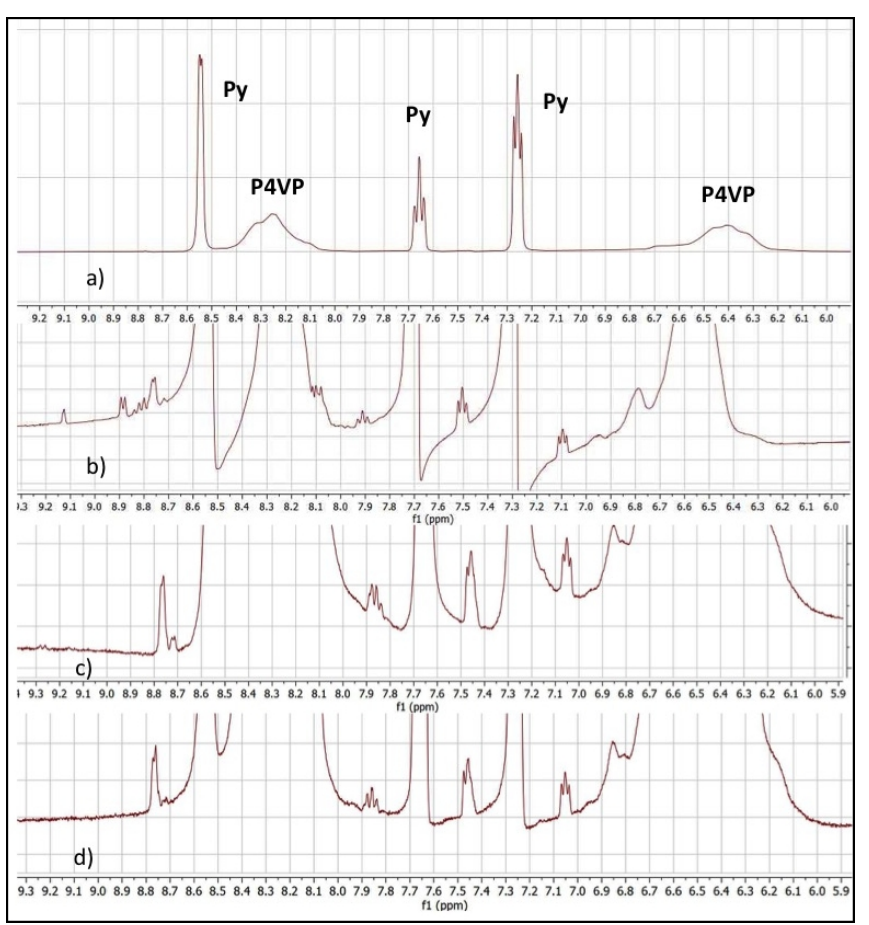
Figure 2. ( a ) 1 H NMR spectrum of P4VP/Py gel before irradiation; ( b ) after 1 h irradiation of P4VP/Py gel at 312 nm; ( c ) after 6 h irradiation at 312 nm; ( d ) after 6 h irradiation of P4VP/Py gel and subsequent 24 h storage in the dark.